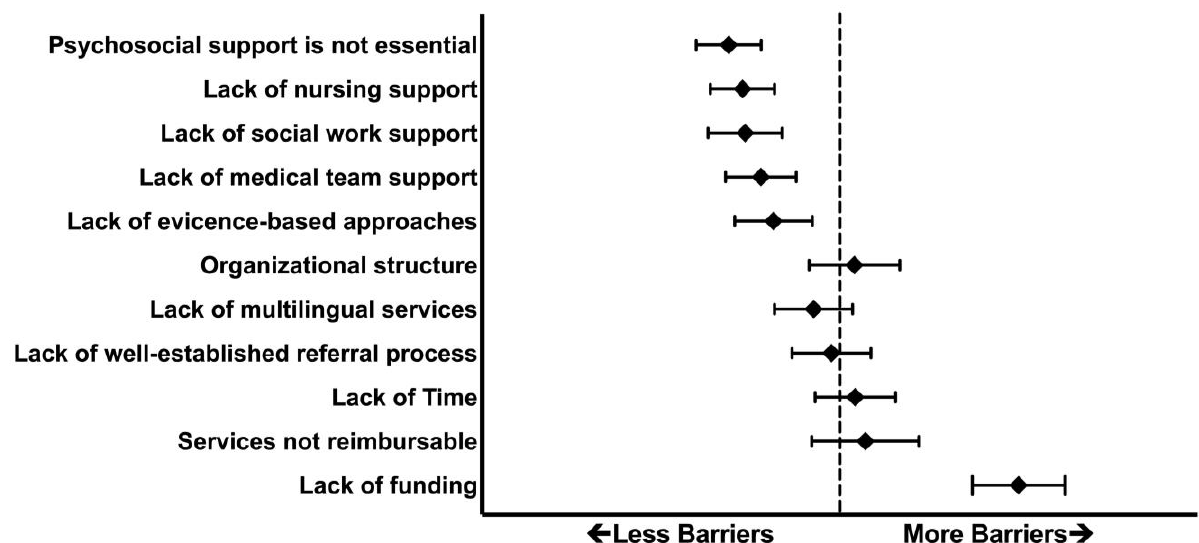
Figure 1. Challenges and Barriers to Caregiver Psychosocial Care in the NICU. Figure 1 Participants rated potential barriers to psychosocial care on a scale of 0 – 3, with 0 indicating “ not a barrier ” and 3 indicating a “ major barrier ” . Data shown are the mean ± 95% confidence interval for each category. The dashed vertical line represents a rating of 2, corresponding with a “ moderate barrier ” .